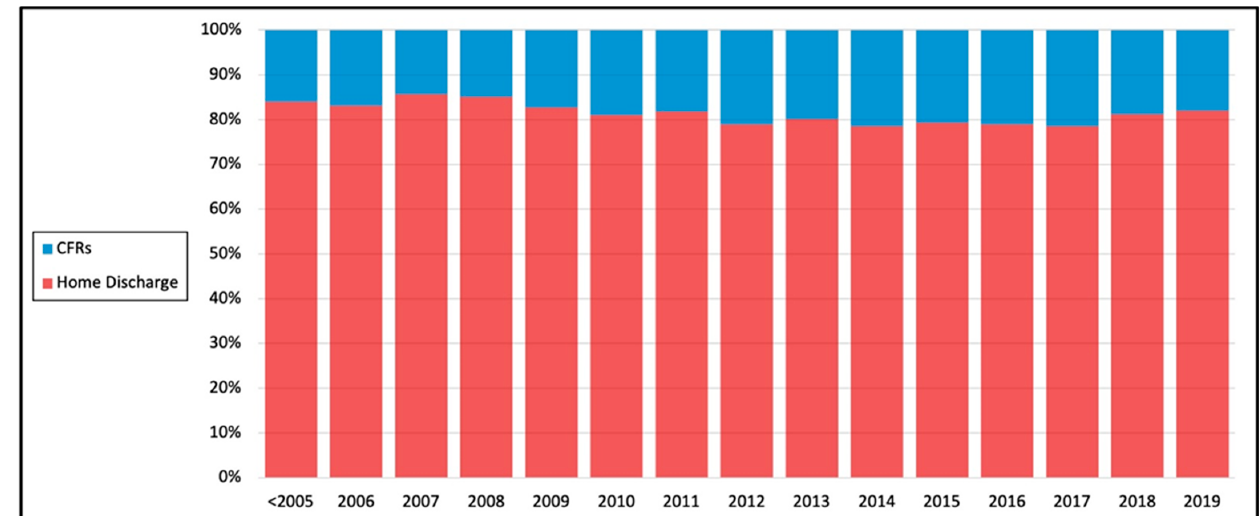
Figure 1. Trends over time of patients discharged home vs. to CFRs in the United States.